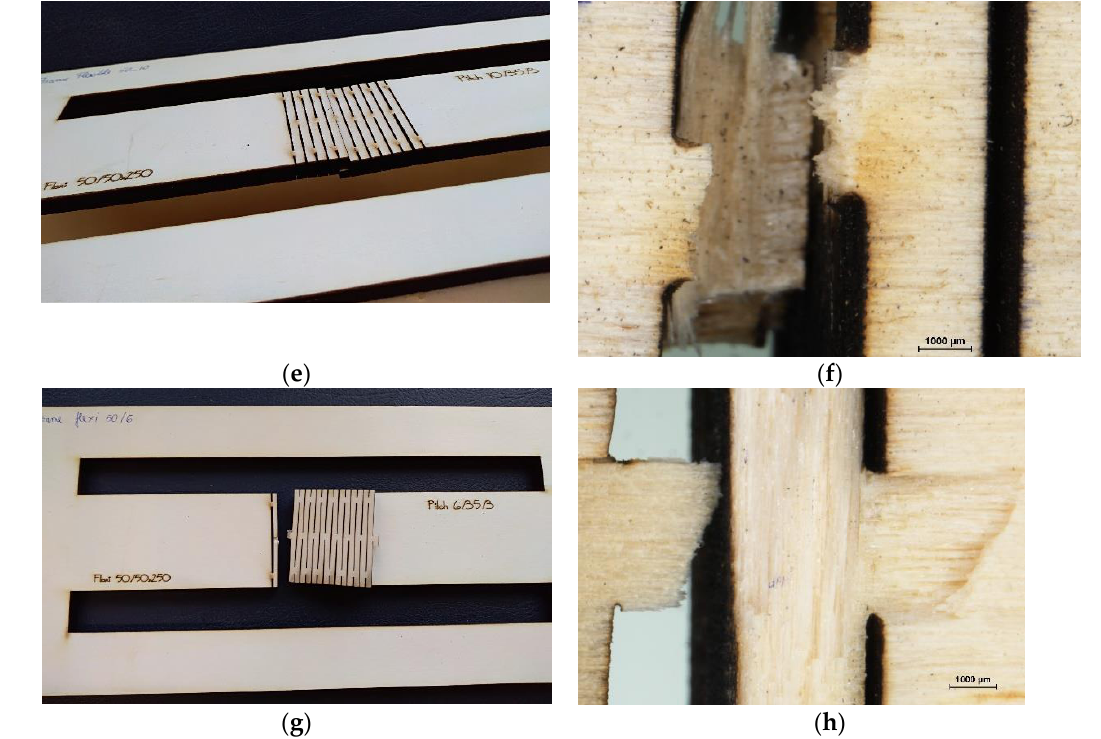
Figure 6. Failure of test specimens: ( a , b ) standard; ( c , d ) simple flexible; ( e , f ) frame flexible-central failure; ( g , h ) frame flexible-side failure. Micrographs ( b , d , f , h ) have 22.5× magnification.